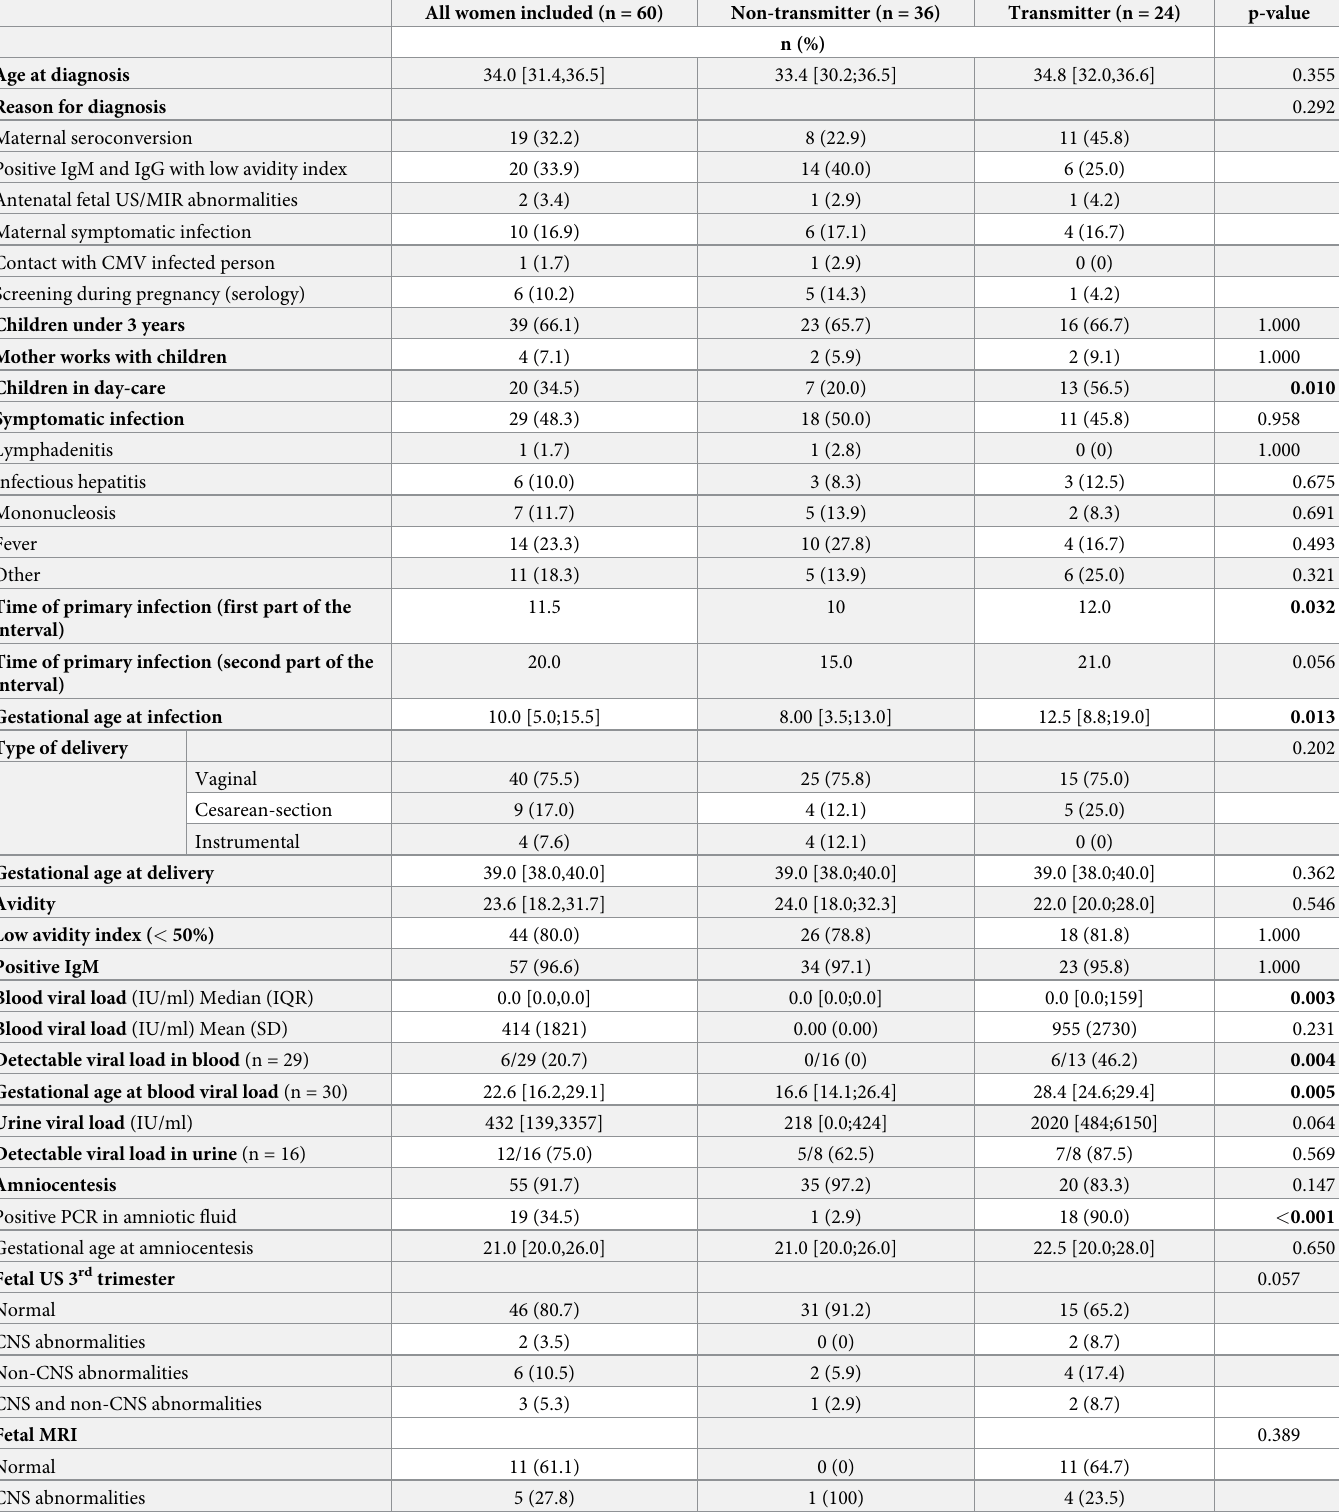
Table 1. Demographic data of the 60 women with a primary CMV infection during pregnancy studied here. All women included (n =